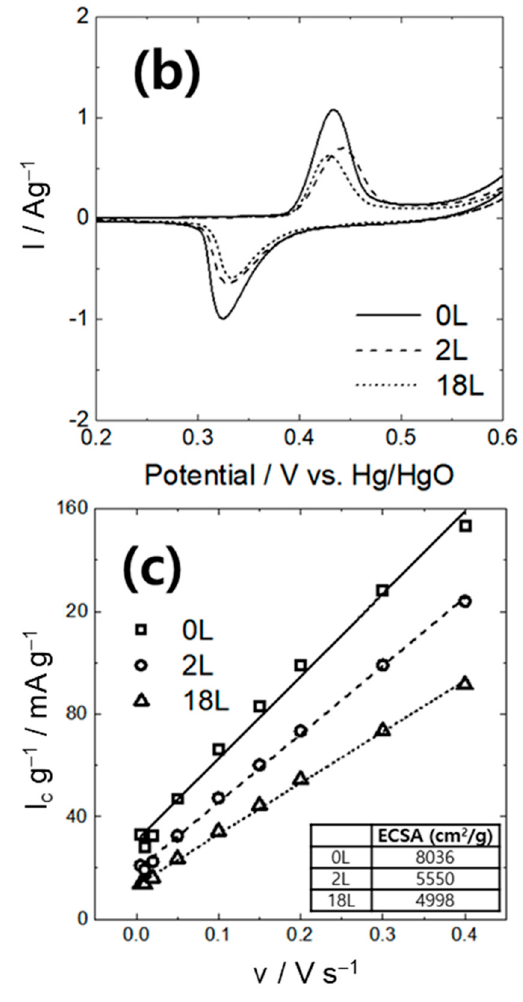
Figure 4. ( a ) The first and ( b ) the second cyclic voltammograms and ( c ) a charging current vs. scan rate plot (inset table is the estimated ECSA values), obtained from the nickel phosphide nanowires prepared at different values of magnetic field strength (Samples 0L, 2L, and 18L).